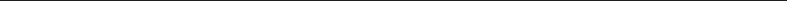
Table 3. RRT procedure to assess cognitive doping.